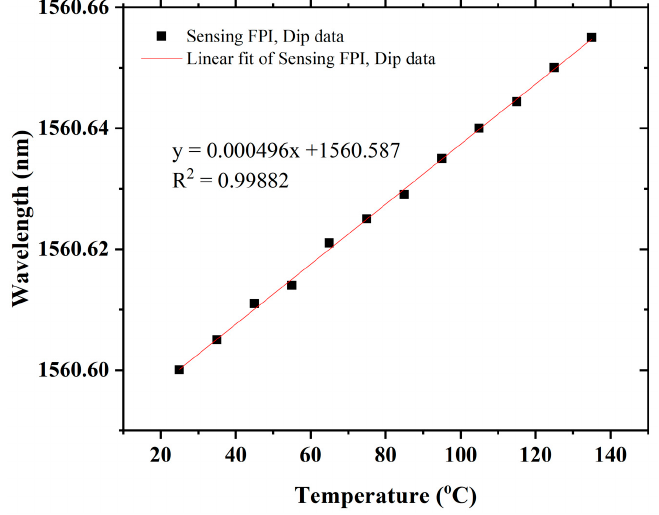
Figure 14. Sensitivity and linear correlation function.